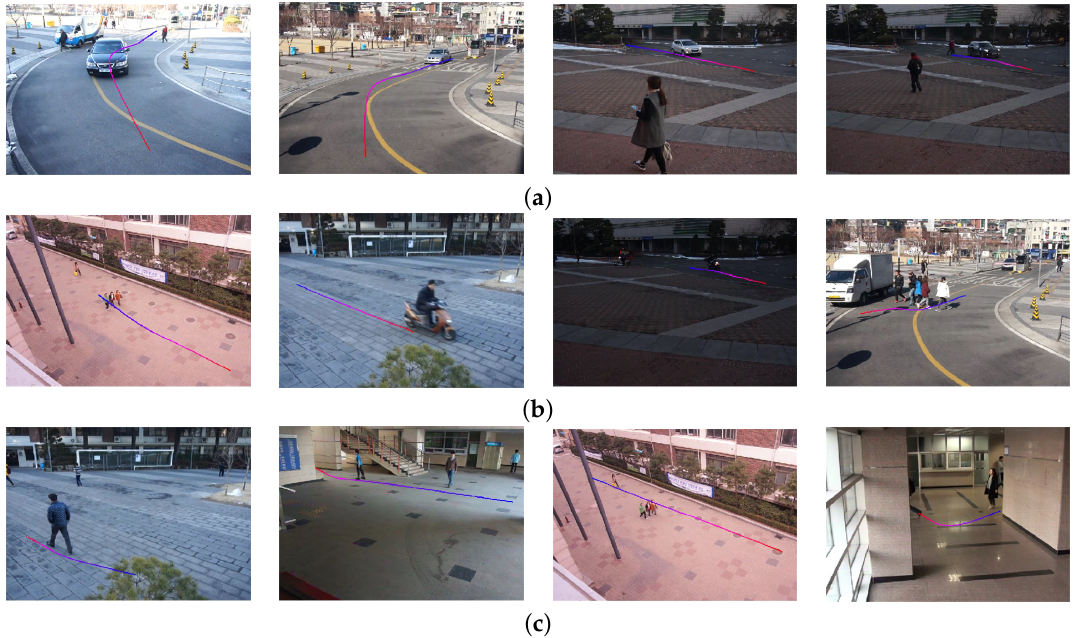
Figure 18. Results of the object search using the object ratio. ( a ) Horizontal; ( b ) normal; ( c ) vertical.